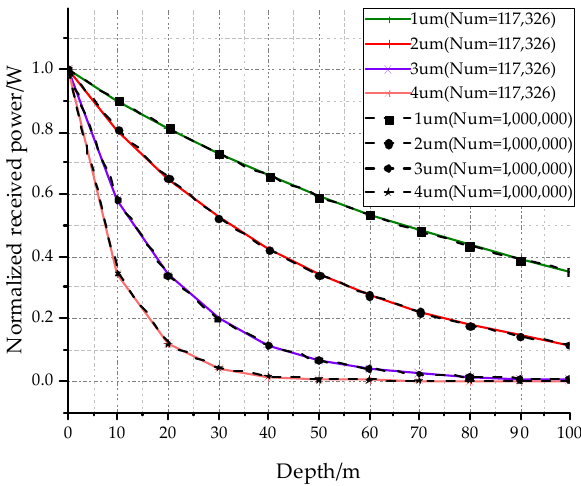
Figure 7. Normalized received power varies with depth when the initial photon numbers were set at 117,326 and 1,000,000. Table 8. The comparison of simulation time.